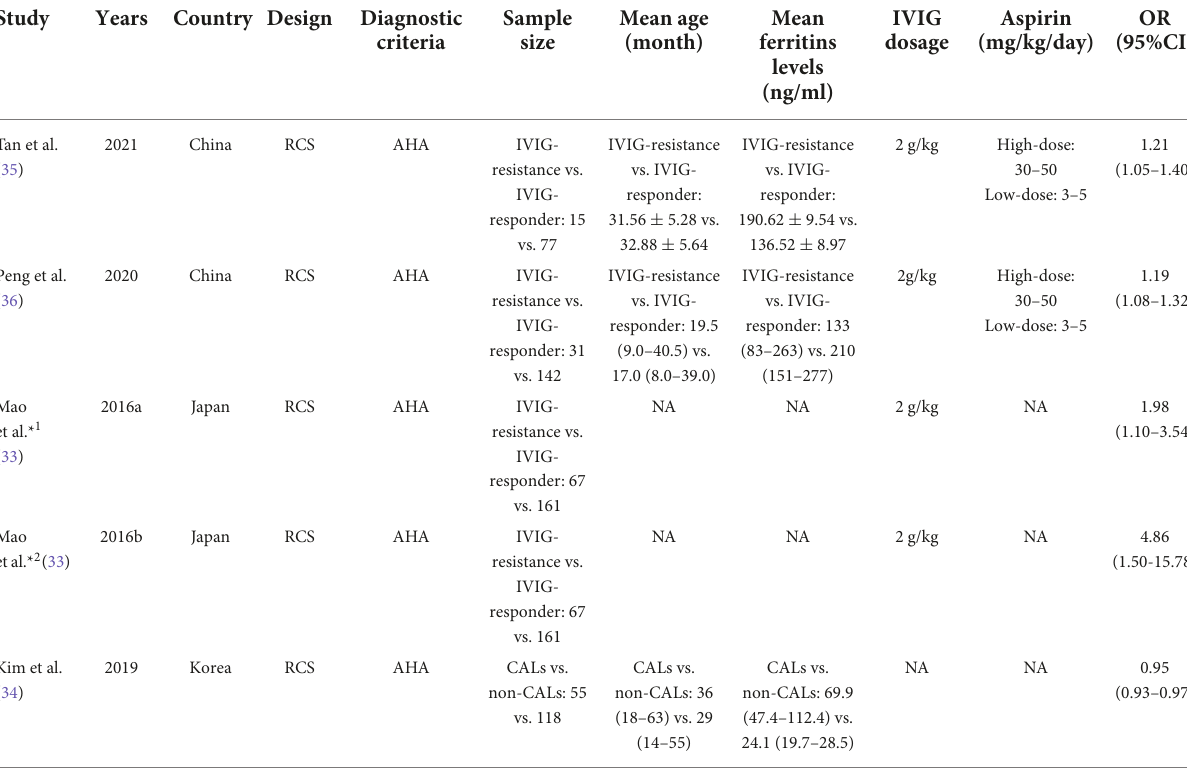
TABLE 3 Characteristics of studies in prognostic